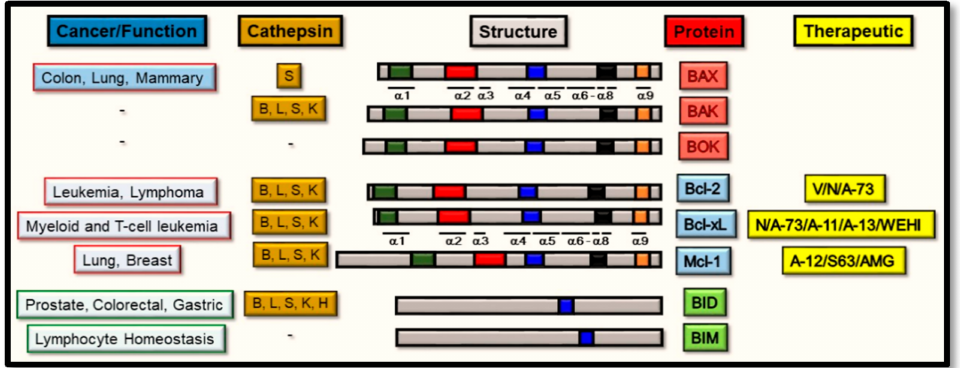
Figure 1. Schematic representation of the structural architecture of the Bcl-2 proteins, with the diseases (or function) and current therapeutics or cathepsin proteases associated with each of them. The three main groups of Bcl-2 family composed of pro-apoptotic, anti-apoptotic and BH3-only proteins are highlighted showing their structural domains as orange (trans-membrane domain), blue, black, red, and green boxes as the Bcl-2 homology (BH) domains 1–4 (respectively) along with the cathepsins that cleave them. The therapeutics active for the stated Bcl-2 proteins are V (Venetoclax), N (Navitoclax), A-73 (ABT-737), A-11 (A-1165463), A-13 (A-1331852), WEHI (WEHI-539), A-12 (A-1210477), S63 (S63845), and AMG